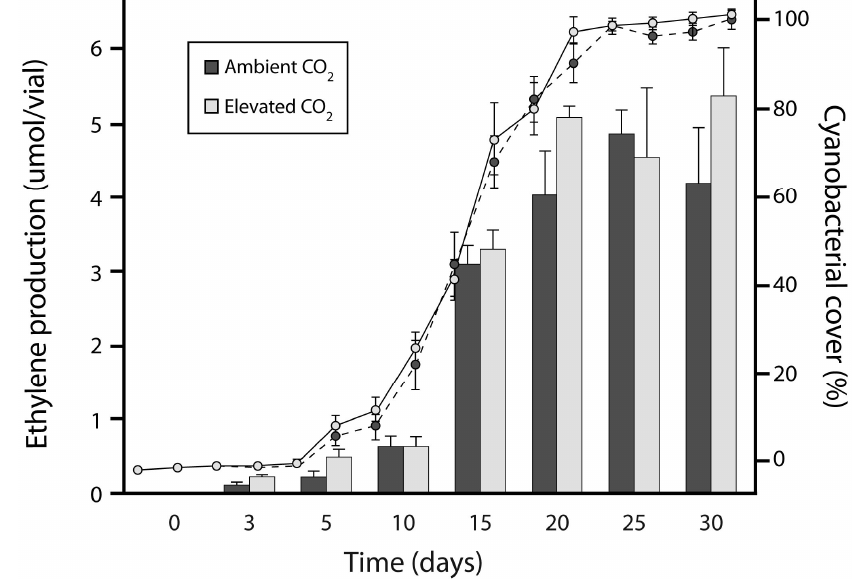
Figure 1. Cyanobacterial growth (circles) and N fixation (bars) as measured by the ethylene (C 2 H 4 ) produced of N. punctiforme cultures over 30 days. Samples were grown on 27 mm diameter agar vials over 30 days under ambient (430 ppm) and elevated (750 ppm) atmospheric CO 2 conditions. All data are plotted as mean ± SD.